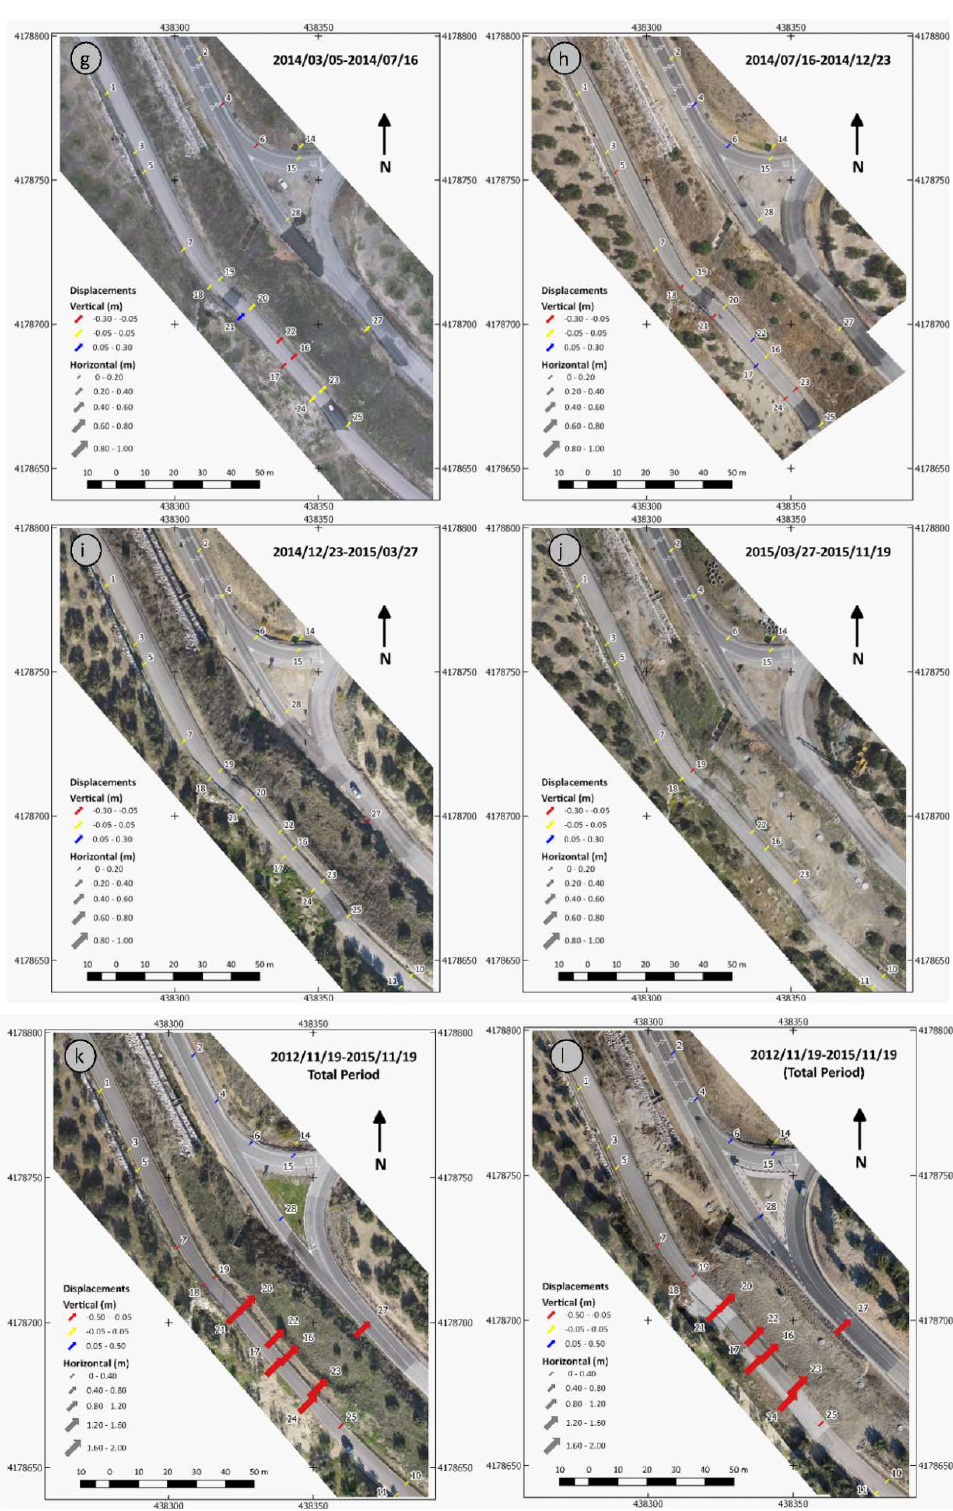
Figure 7. Maps of displacements of monitoring points for the different periods. ( a ) 19 November 2012–